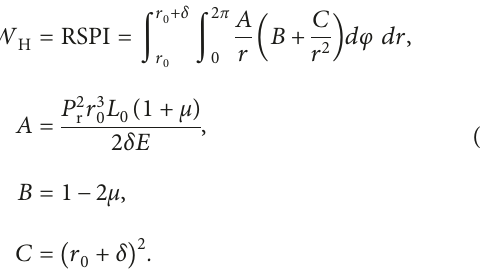
Figure 5. The radial swelling pressures were less than 0.125 MPa at the initial swelling stage (0–16th hour). How- swelling stage (17th hour–240th hour) are 1.526 MPa, 1.614 MPa, 2.057 MPa, and 2.08 MPa in test nos. 1, 2, 3, and 4,